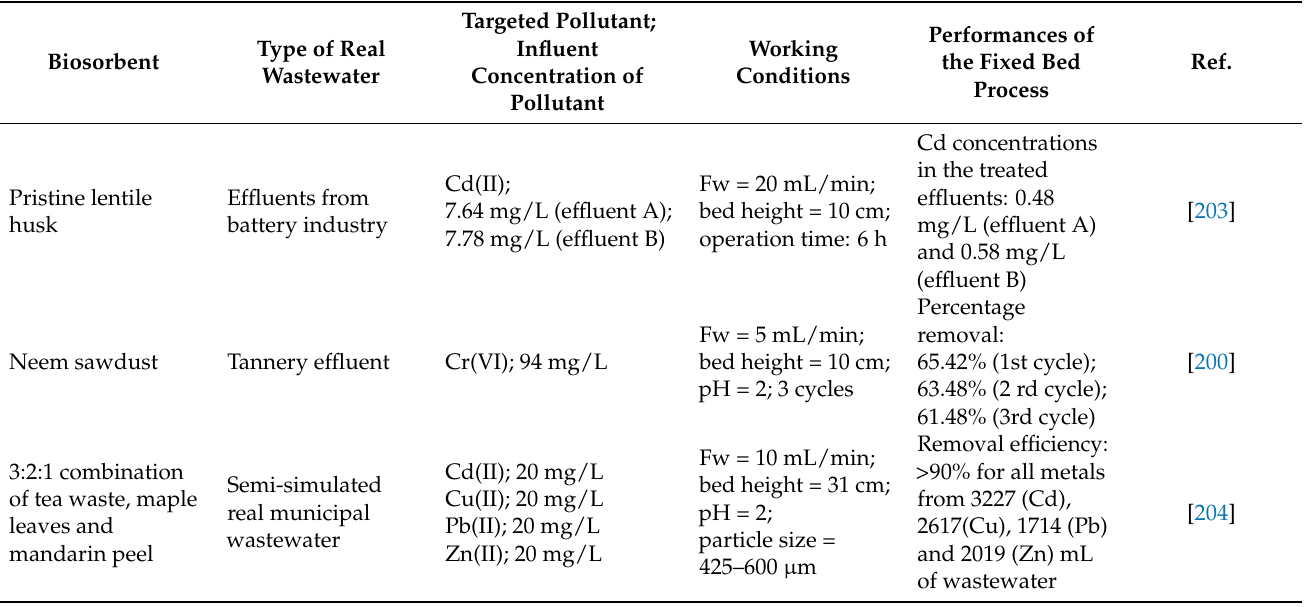
Table 5. Renewable resource biosorbents for the removal of pollutants from real wastewater in continuous flow